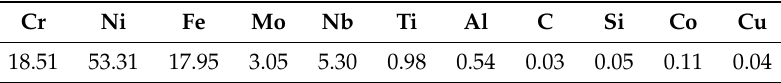
Table 1. Nominal chemical composite of IN718 (wt, %).